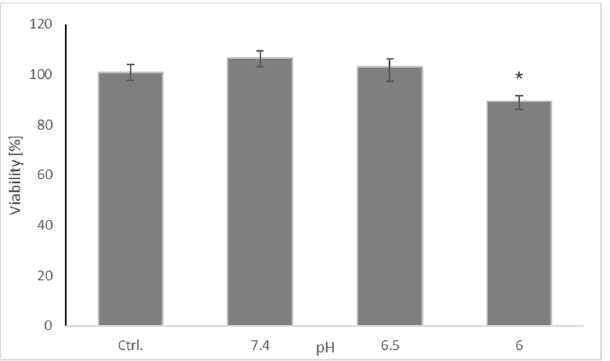
Figure 2. Effect of pH on the viability of SH-SY5Y cells. Cell viability was estimated with Presto Blue. The whiskers are lower (25%) and upper (75%) quartile ranges. * p ≤ 0.05, Kruskal–Wallis test vs. control (Ctrl); n = 9.